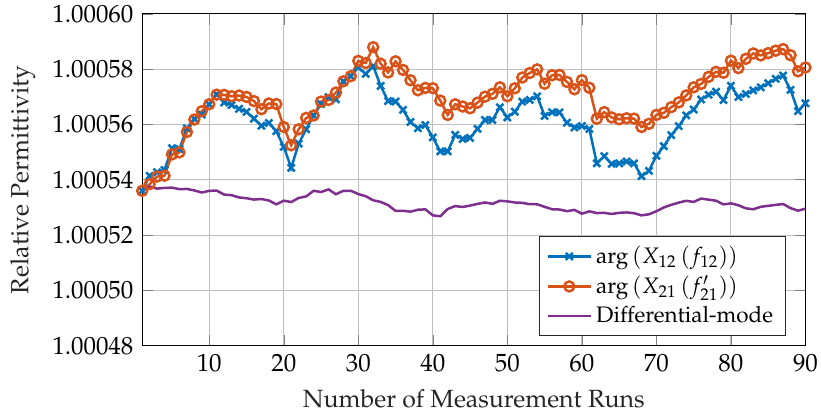
Figure 9. Relative permittivity of air filled gas container calculated from phase-based time-of-flight (TOF) over 90 consecutive measurement runs with two synchronized low-cost radar sensors. Forward and backward transmission path are shown separately as well as after time-variant error compensation.